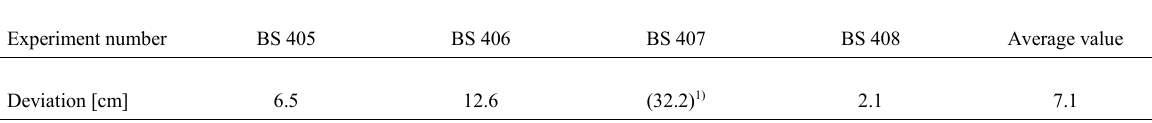
Table 6: Deviation of location of the initial crack from optical determination and acoustic emission